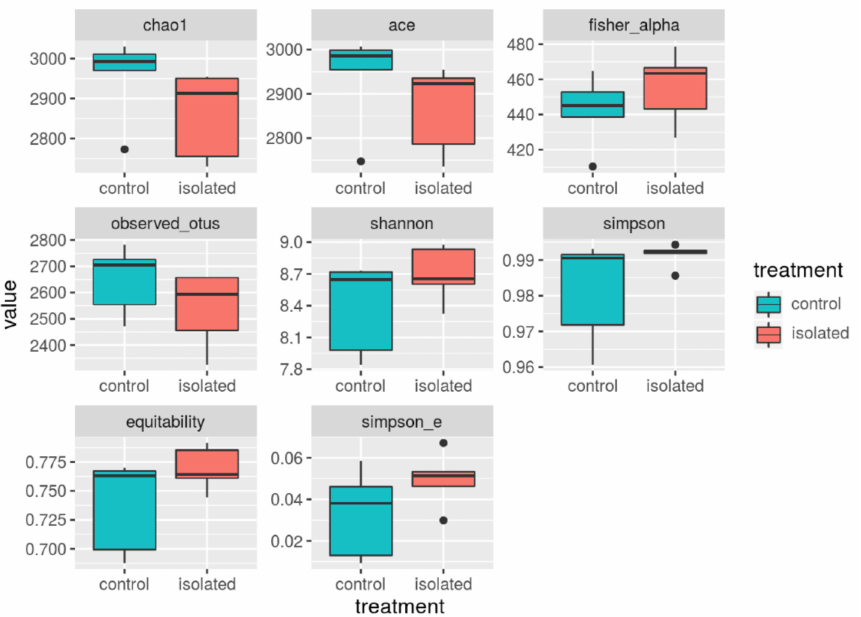
Figure 2. Estimated alpha diversity indices in the sheep hindgut microbiome from the two treat- ment